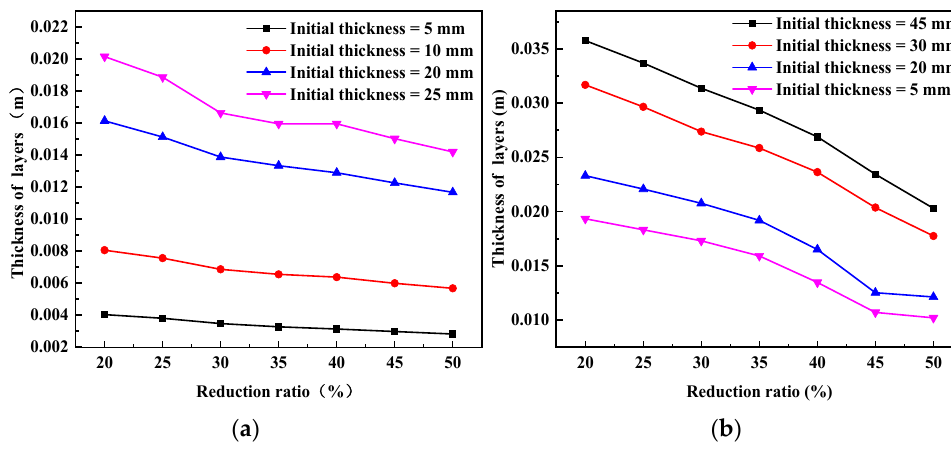
Figure 7. Thickness distribution of each layer at different initial thicknesses. ( a ) Ti ,( b ) Steel.